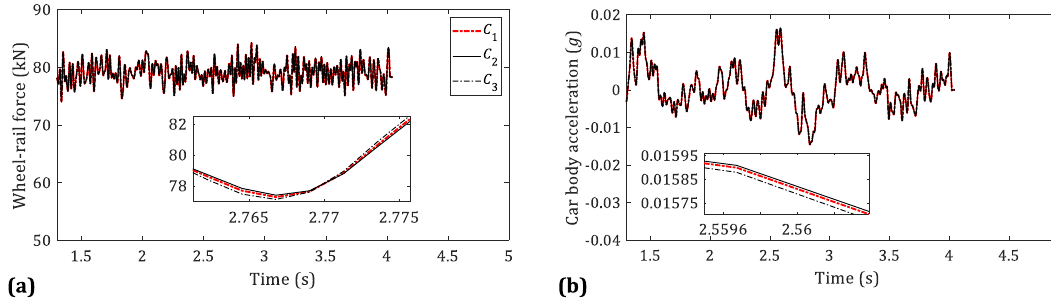
Fig. 15 Comparisons on wheel–rail interaction and car body vibration: a wheel-rail vertical force; b car body vertical acceleration